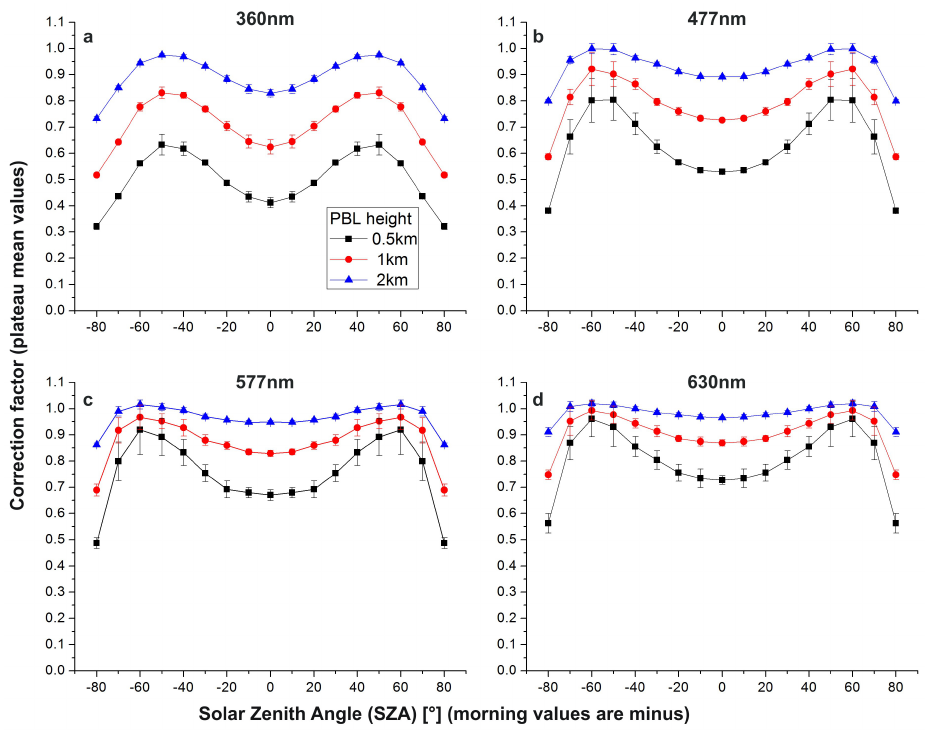
Fig. 4. Correction factor mean values for different PBL heights (0.5km, 1km and 2km) and for the wavelengths (a) 360nm, (b) 477nm, (c) 577nm and (d) 630nm versus solar zenith angle. An AOD range between 0.3 and 0.6 (3 ◦ elevation angle) was used to derive the mean values. For further discussion see text.